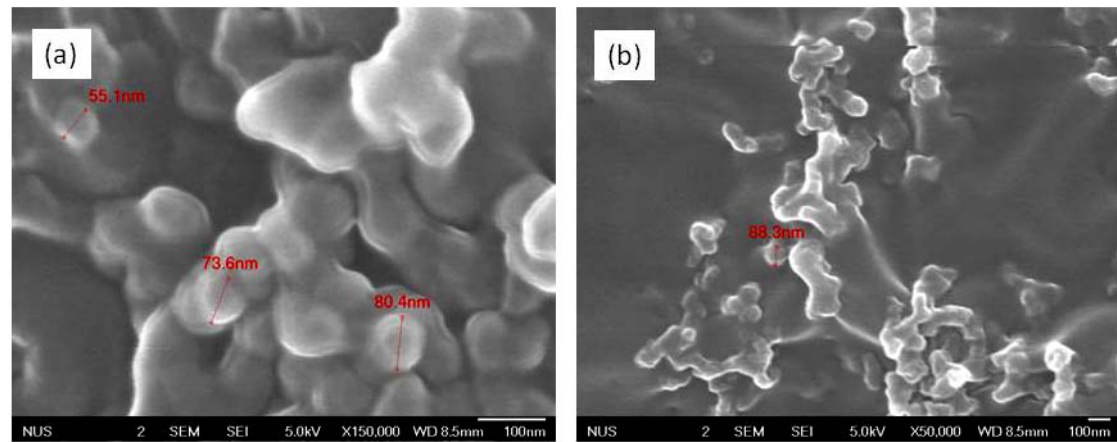
O :PVP support at 150,000 times magnification. 3 4 O :PVP/Au composite at 50,000 times magnification. 3 4